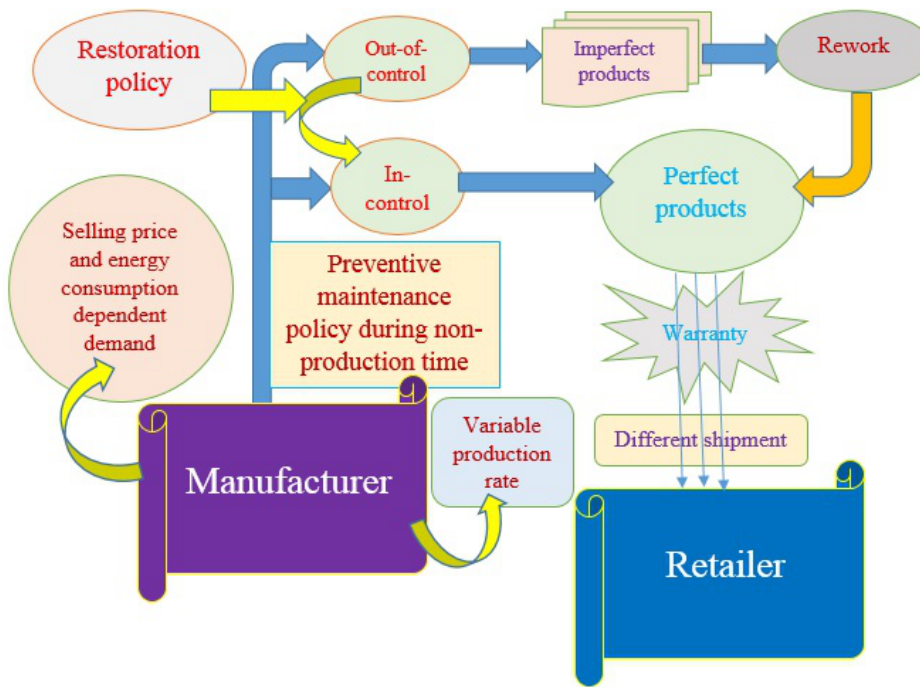
Figure 1. The model structure of proposed supply chain